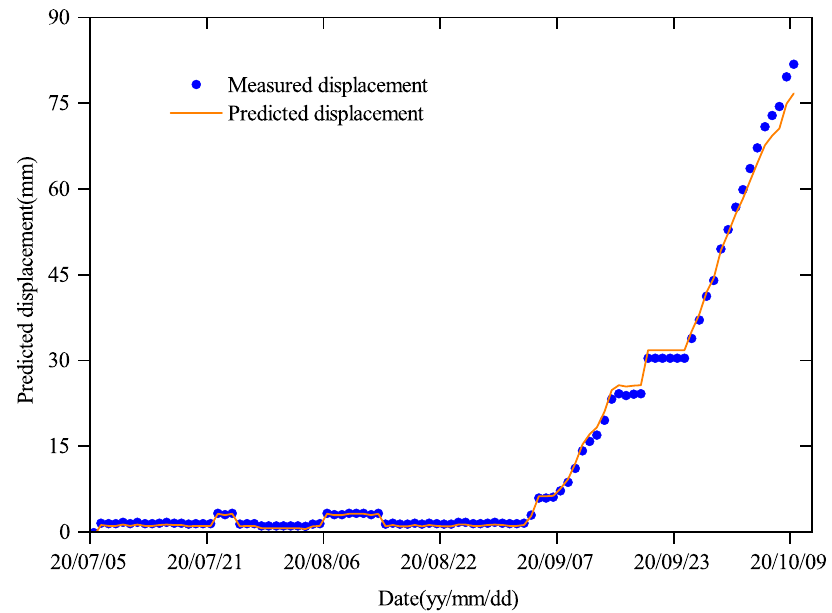
Figure 5. Prediction and comparison of GA-Elman model on training set.